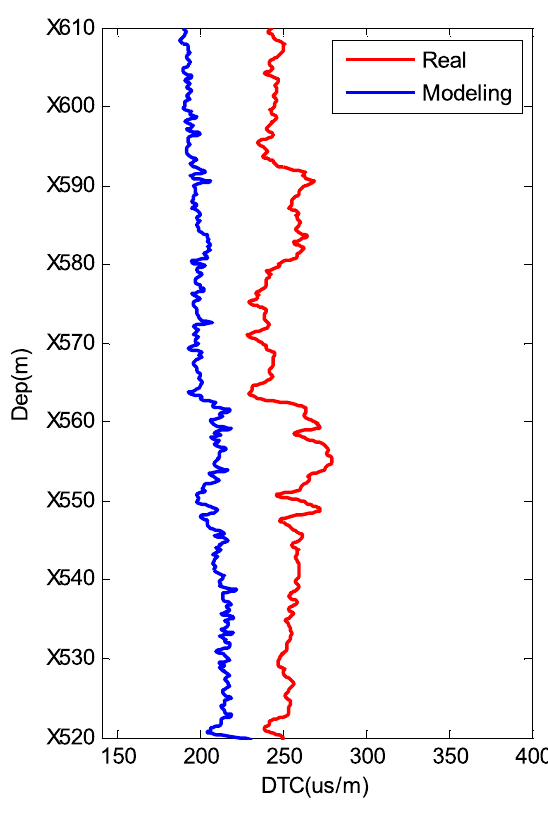
Figure 2. Well logging data of the rock composition in a shale reservoir.